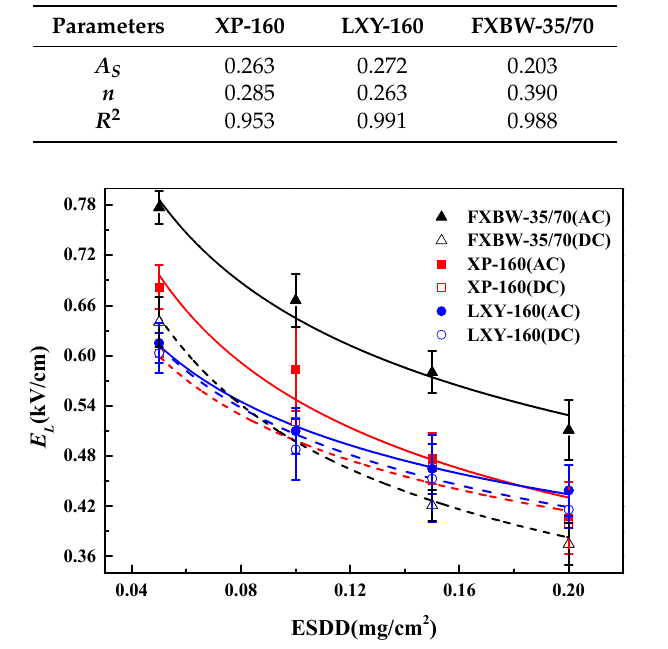
Figure 7. Relationship between E L and ESDD .